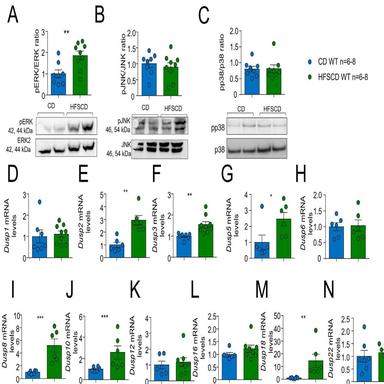
HFSCD feeding in WT mice induced alteration of MAPK signaling cascades and phosphatases. Protein levels of activated phosphorylated (A) ERK (pERK) (B) SAPK/JNK (pJNK) and (C) p38 (pp38) relativized to their unphosphorylated total protein levels determined by western blot analysis. mRNA levels of phosphatases (D) Dusp1, (E) Dusp2, (F) Dusp3, (G) Dusp5, (H) Dusp6, (I) Dusp8, (J) Dusp10, (K) Dusp12, (L) Dusp16, (M) Dusp18 and (N) Dusp22. Representative blots are shown for the phosphorylated and unphosphorylate